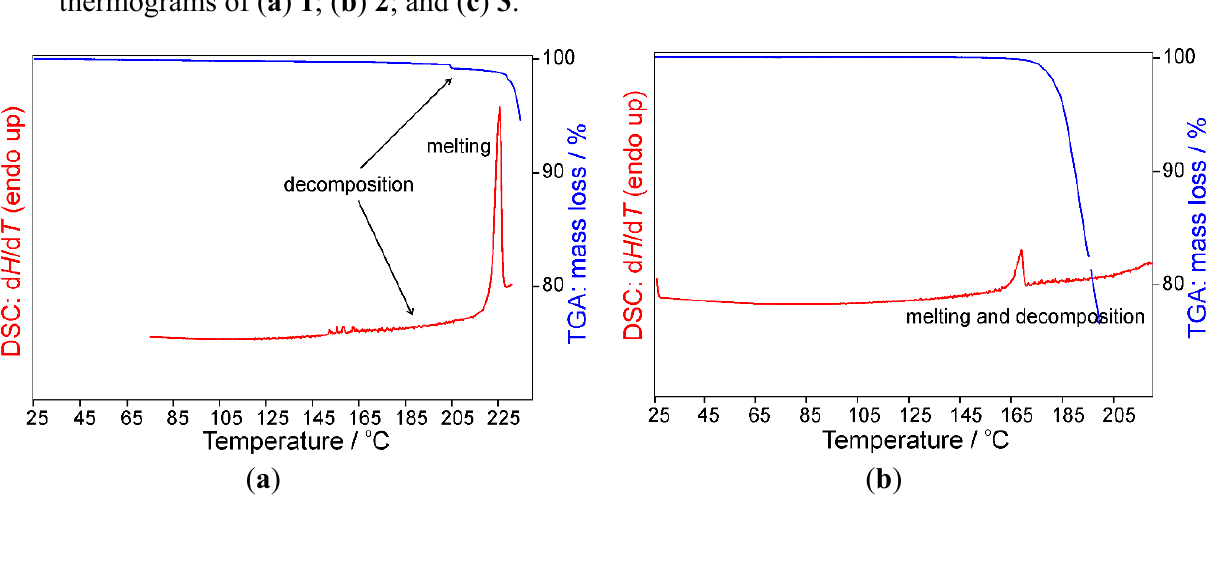
Figure 8. Differential Scanning Calorimetry/Thermogravimetric Analysis (DSC/TGA) thermograms of ( a ) 1 ; ( b ) 2 ; and ( c ) 3